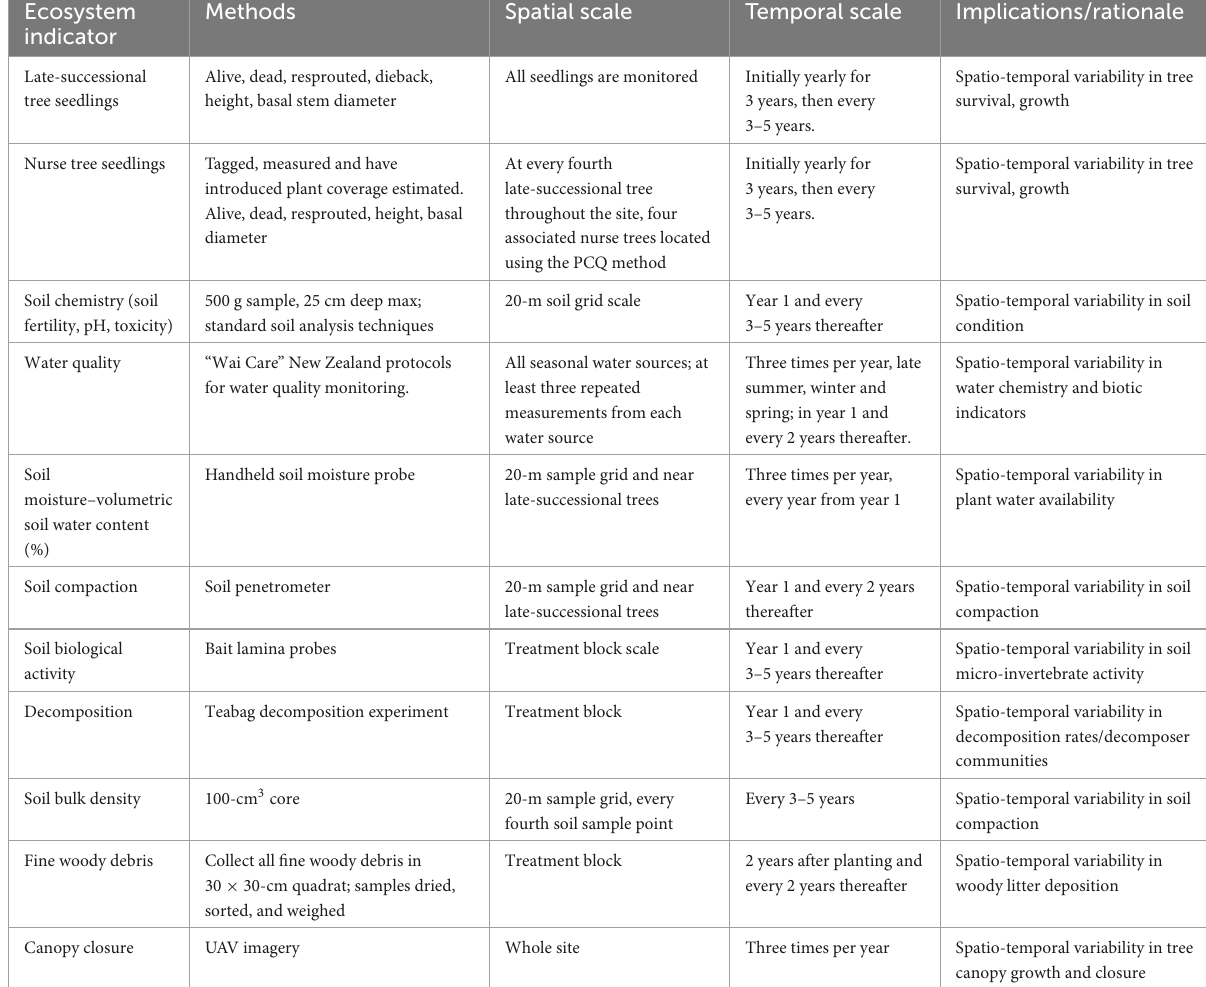
TABLE 4 Monitoring methods for indicators of ecosystem